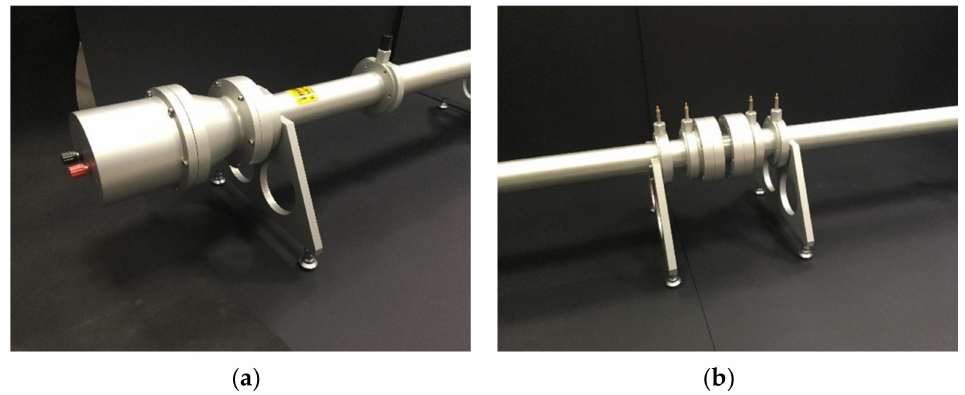
Figure 3. Details of the four-microphone impedance tube: ( a ) the sound source; and ( b ) central part with the inserted sample holder and the two microphone